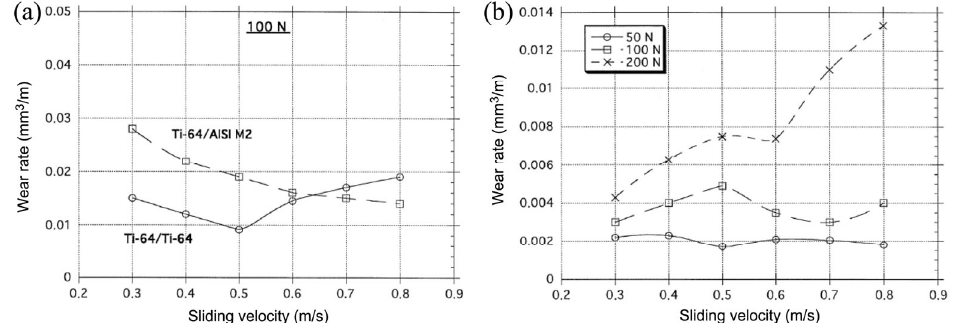
Fig. 22 Wear behavior of Ti64 sliding against similar and AISI M2 steel counter-body surfaces at varying sliding velocities: (a) Ti64 test specimen during Ti64/Ti64 and Ti64/AISI M2 steel interactions (load = 100 N); (b) Ti64 counter-face during Ti64/Ti64 interaction (load = 50, 100 and 200 N). Reproduced with permission from Ref. [29]. Copyright Elsevier, 1999.